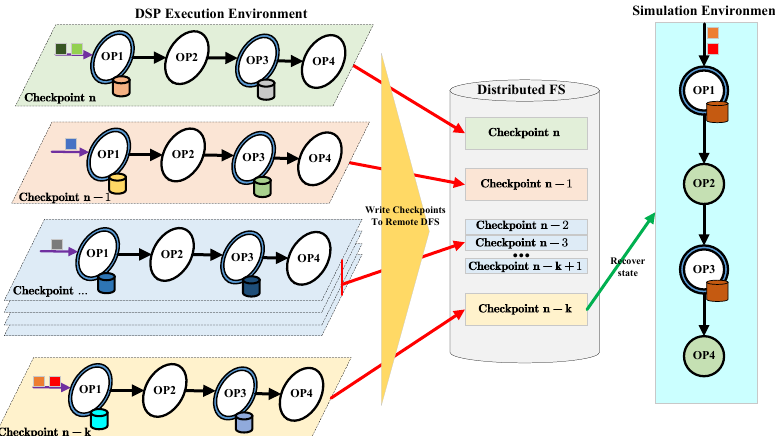
Figure 8. Replaying DSP jobs from one specific checkpoint n-k. First, stateful operators fetch corresponding state values from distributed filesystems and set as their current state. Then source operators ingest the old stream data starting from where checkpoint n-k